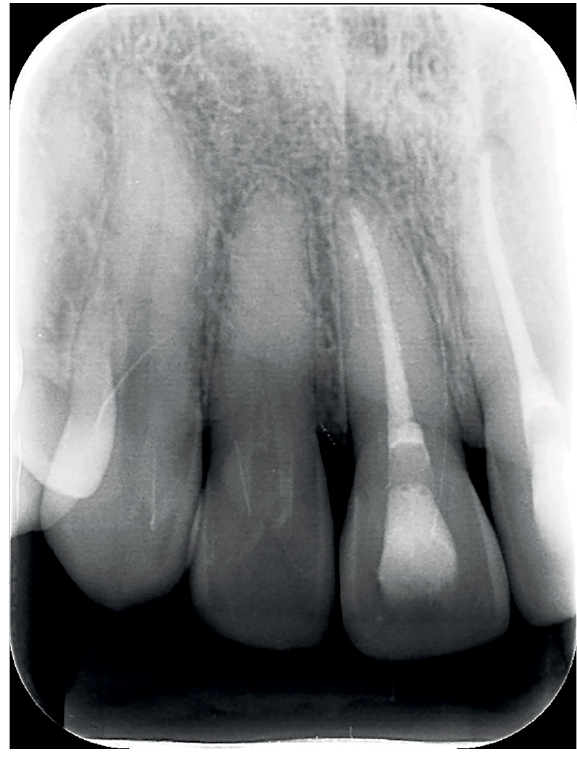
Figure 2. Partial PCO affecting tooth 12 only in the apical third of the root canal. TDI was classified as